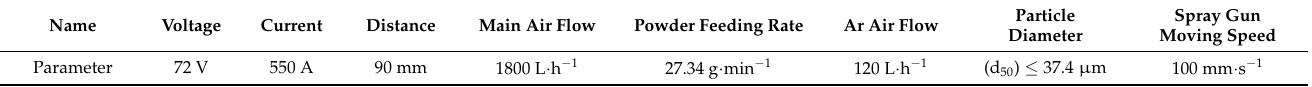
Table 1. Parameters of TiB 2 coating prepared via atmospheric plasma spraying